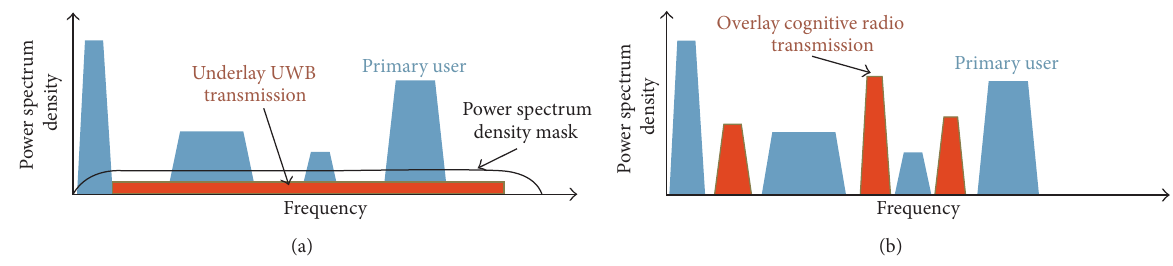
Figure 1: Hierarchal spectrum sharing approaches. (a) Spectrum underlay. (b) Spectrum overlay